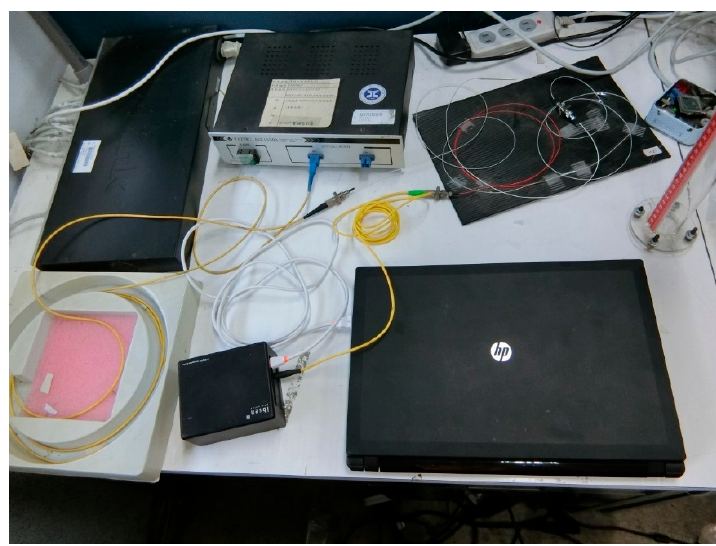
Figure 4. Experimental setup for the hydrostatic pressure and liquid level measurements.